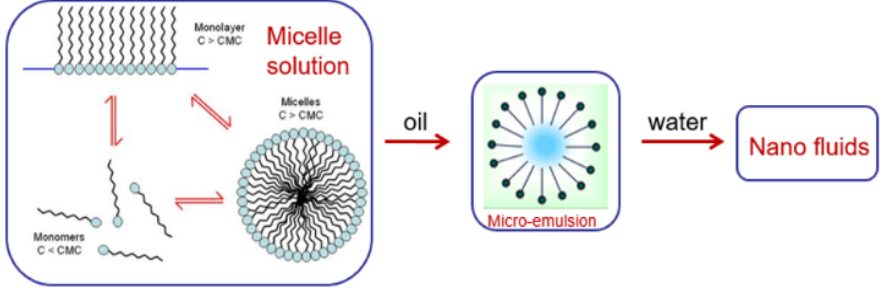
Figure 13. Nano wetting fluid synthesis composite map.